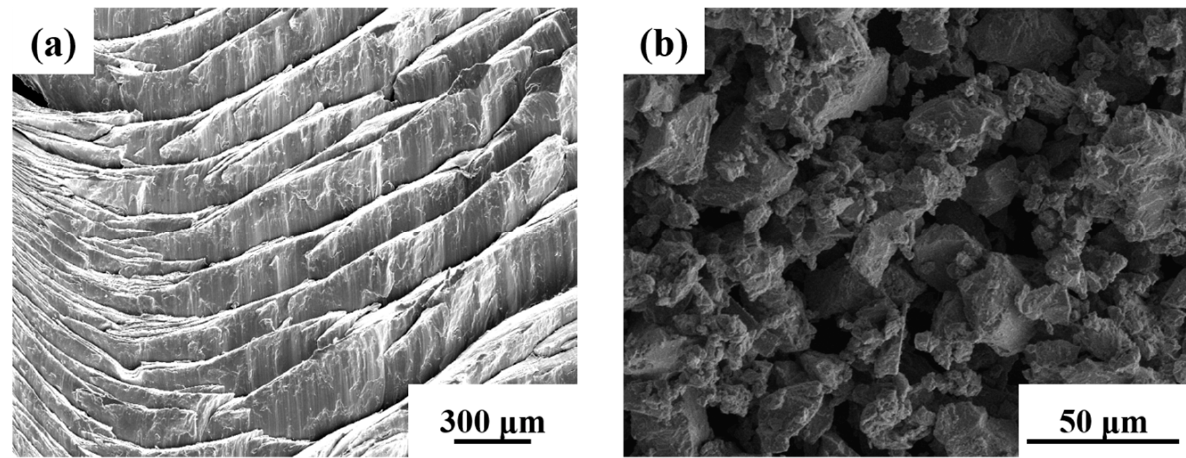
Figure 1. The morphology of initial materials: ( a ) AZ31 Mg alloy chips and ( b ) V particles.